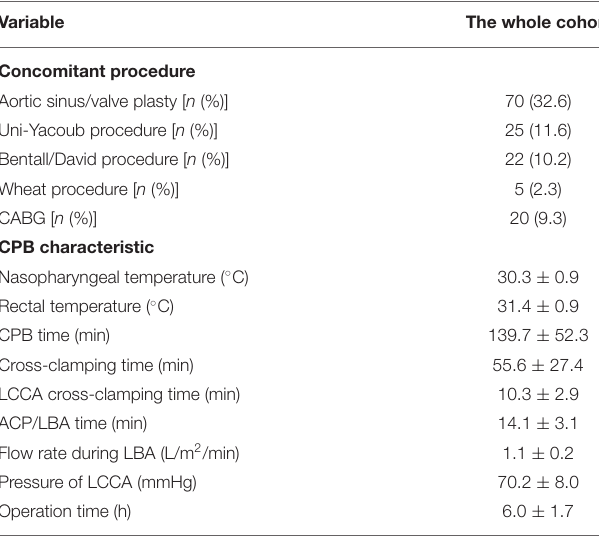
TABLE 3 | Operative outcomes of 215 consecutive patients with ADIAD who underwent treatment using the Brain-Heart-first strategy. Variable